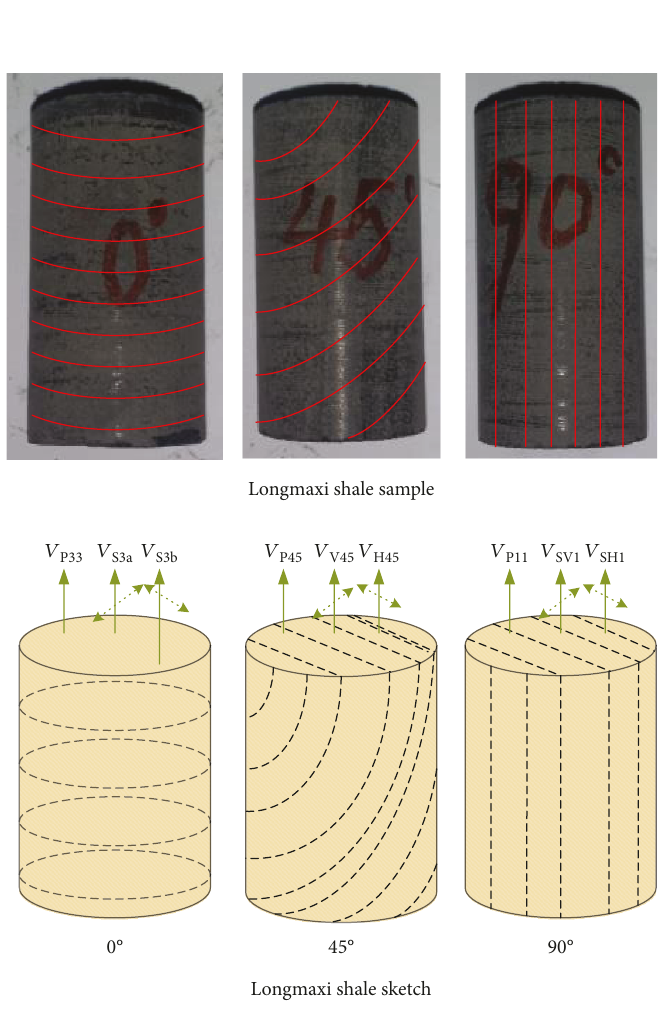
Figure 1: Schematic showing the three-plug method for anisotropic